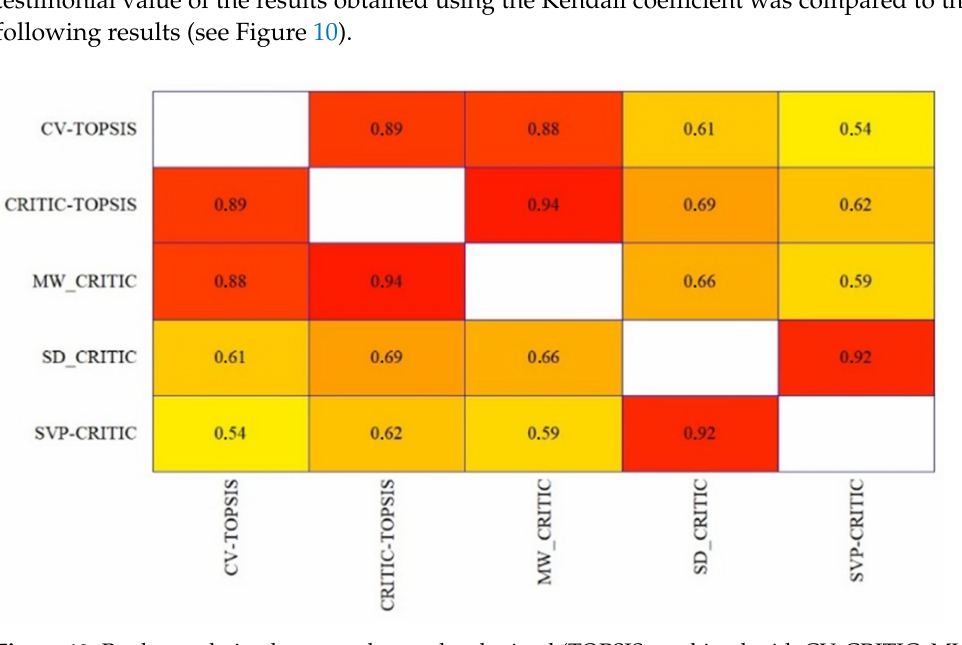
Figure 10. Rank correlation between the results obtained (TOPSIS combined with CV, CRITIC, MW, SD and SVP).